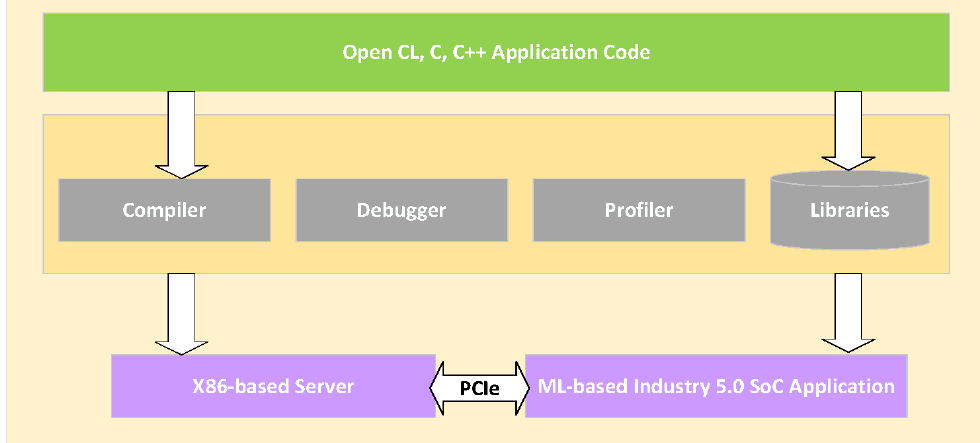
Figure 11. High-level architecture of SDAccel